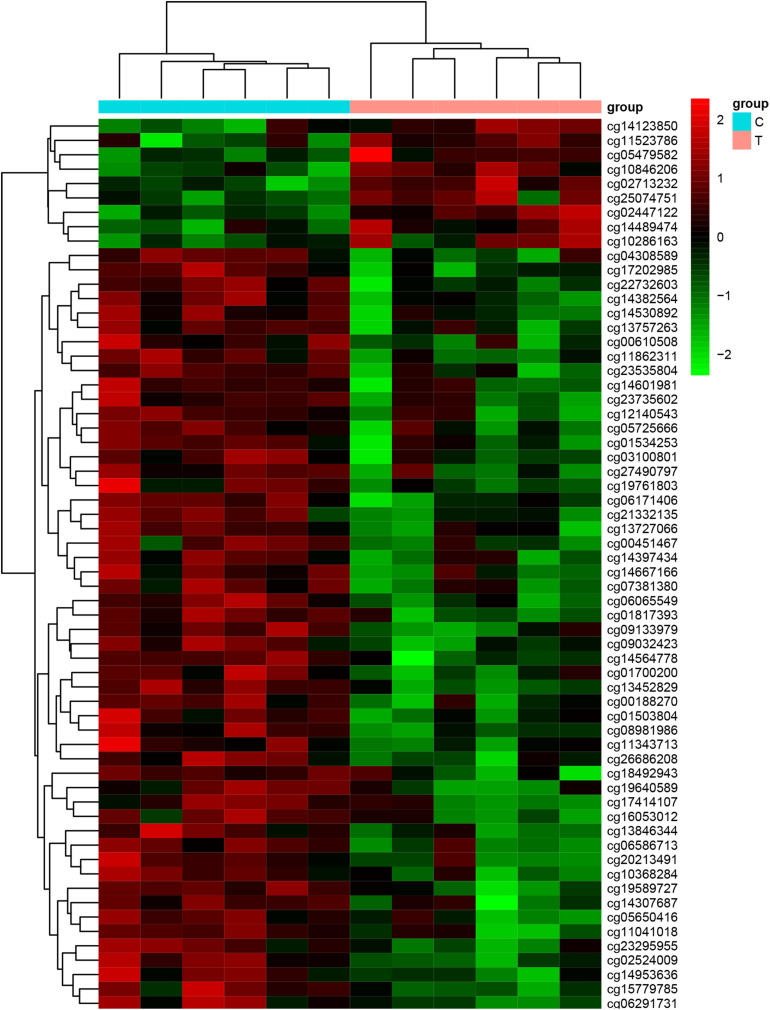
Heat map generated from clustering analysis indicating differentially methylated DNA sites of the whole blood genes of the control (n = 6) and CR (n = 6) groups (C, the patients with non-CR; T, the patients with CR).